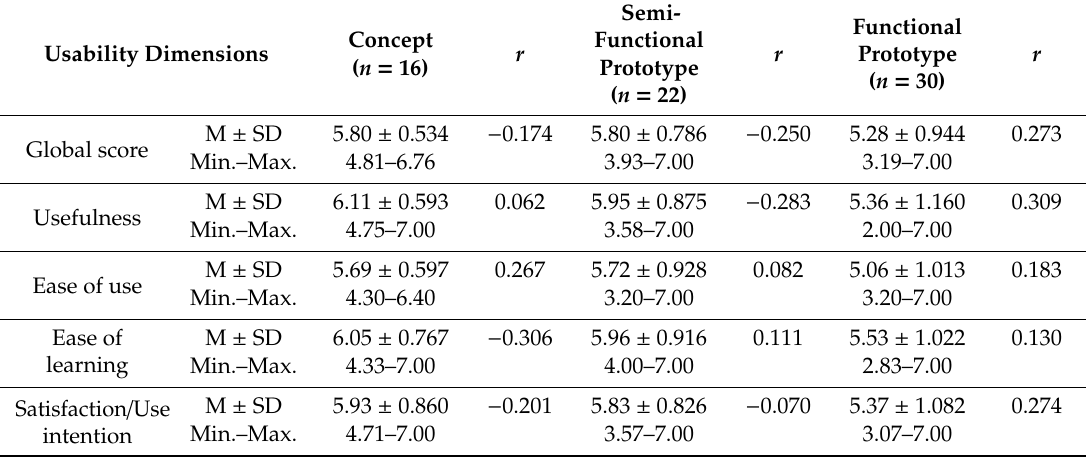
Table 6. Evaluation of the MD: Quantitative